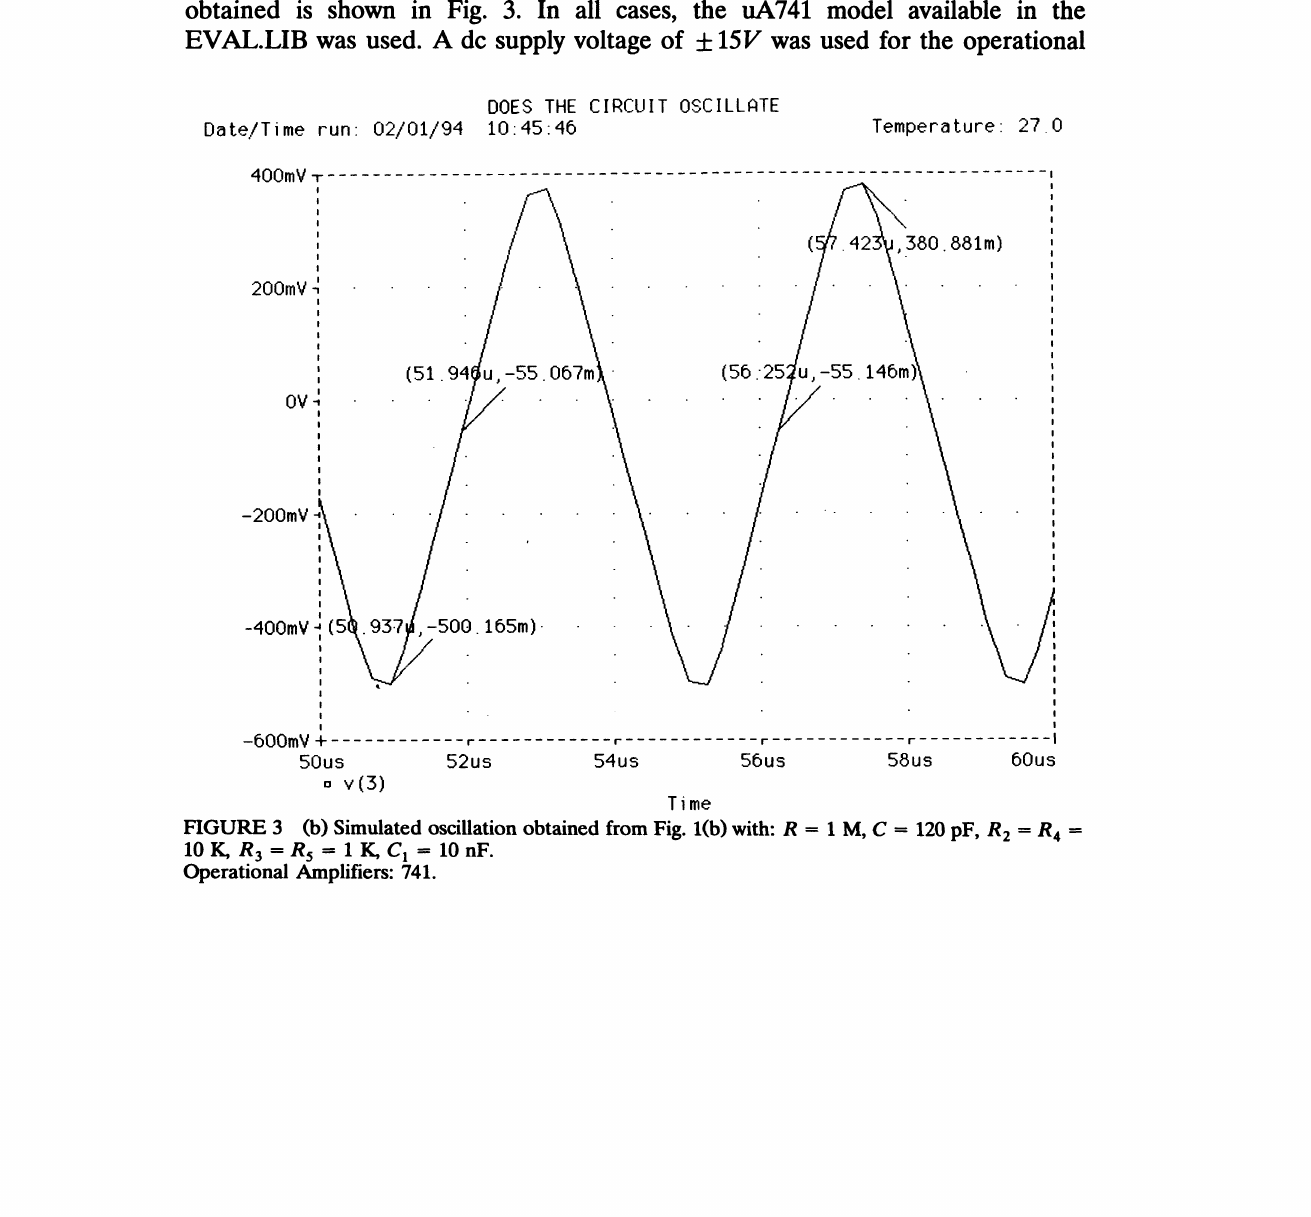
FIGURE 3 (b) Simulated oscillation obtained from Fig. l(b) with: